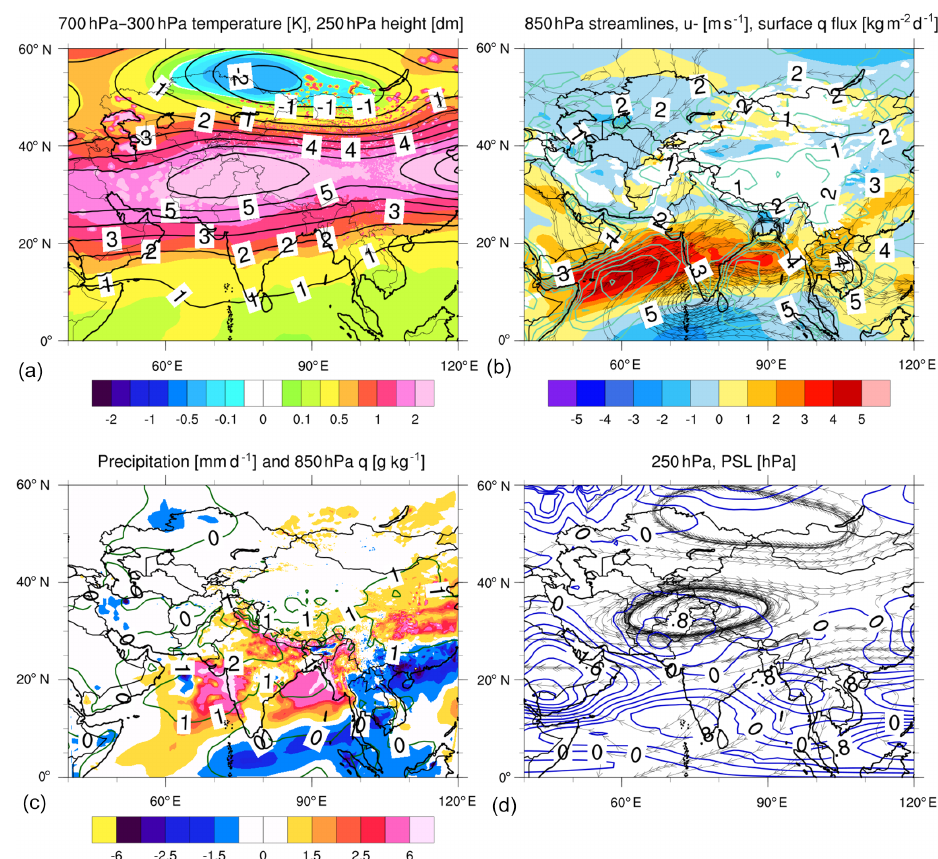
Figure 13. MJ averaged BCD-induced anomalies in (a) 700–300hPa column temperatures and 250hPa heights; (b) 850hPa u anomalies (color fill), streamlines, and surface moisture flux (aquamarine contours); (c) precipitation rate (color fill) and 850 hPa specific humidity (dark green contours); and (d) 250hPa streamlines and surface